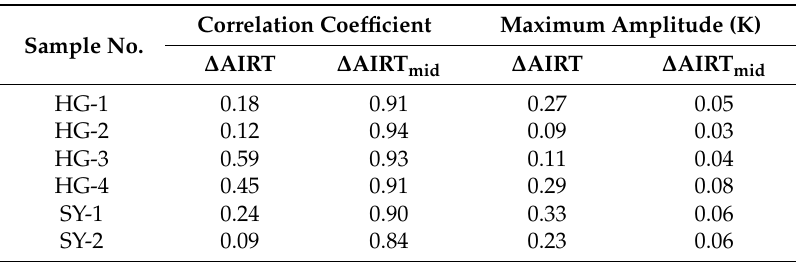
Table 2. Statistical results of the correlation coefficients between both of ∆ AIRT and ∆ AIRT mid and stress and the maximum amplitude.